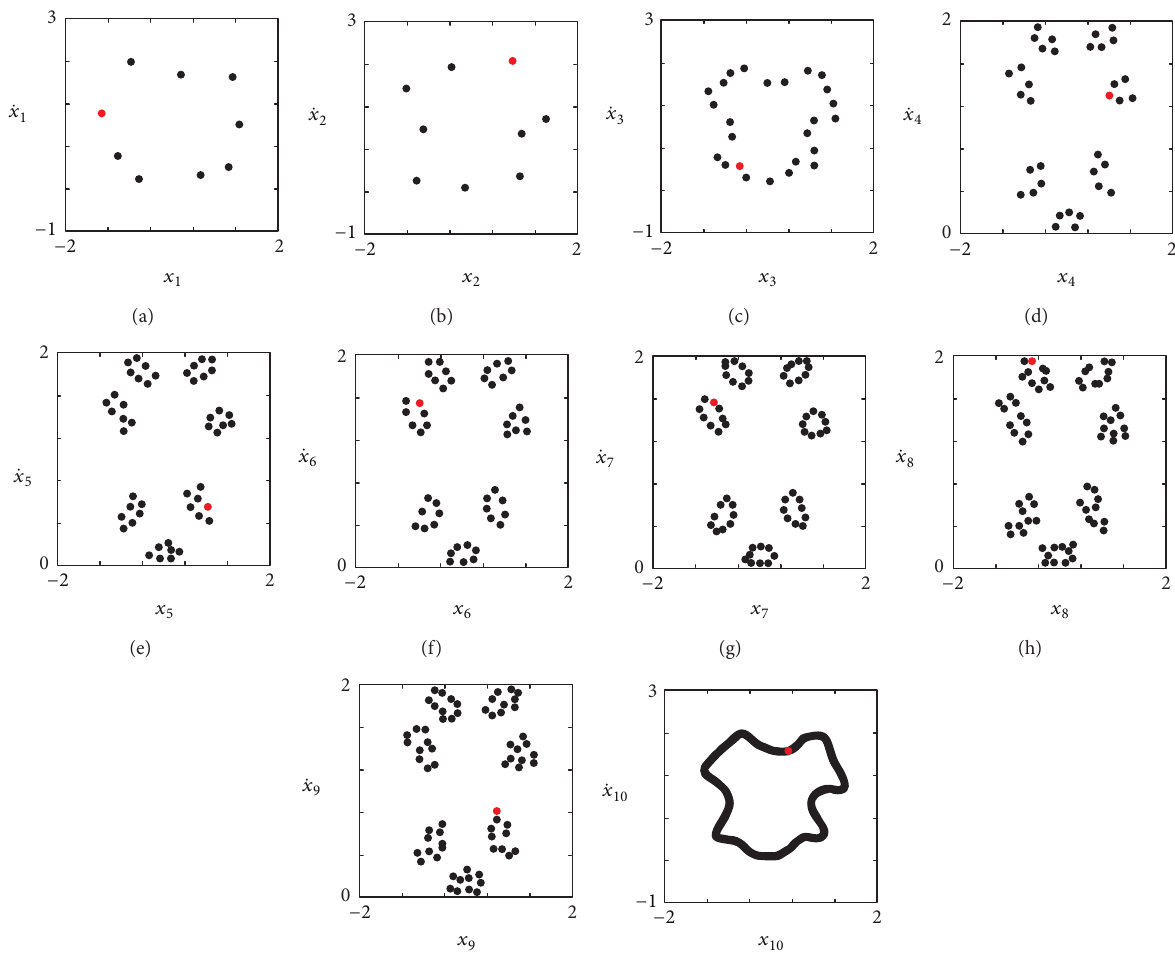
Figure 1: Poincar´e maps of the subsystems of (1) for different initial conditions and 𝜀 = 0 . Maps (a)–(i) show periodic solutions, where the period is equal to number of dots on map multiplied by 2𝜋/0.962 (period of the excitation). The last map (j) represents quasiperiodic